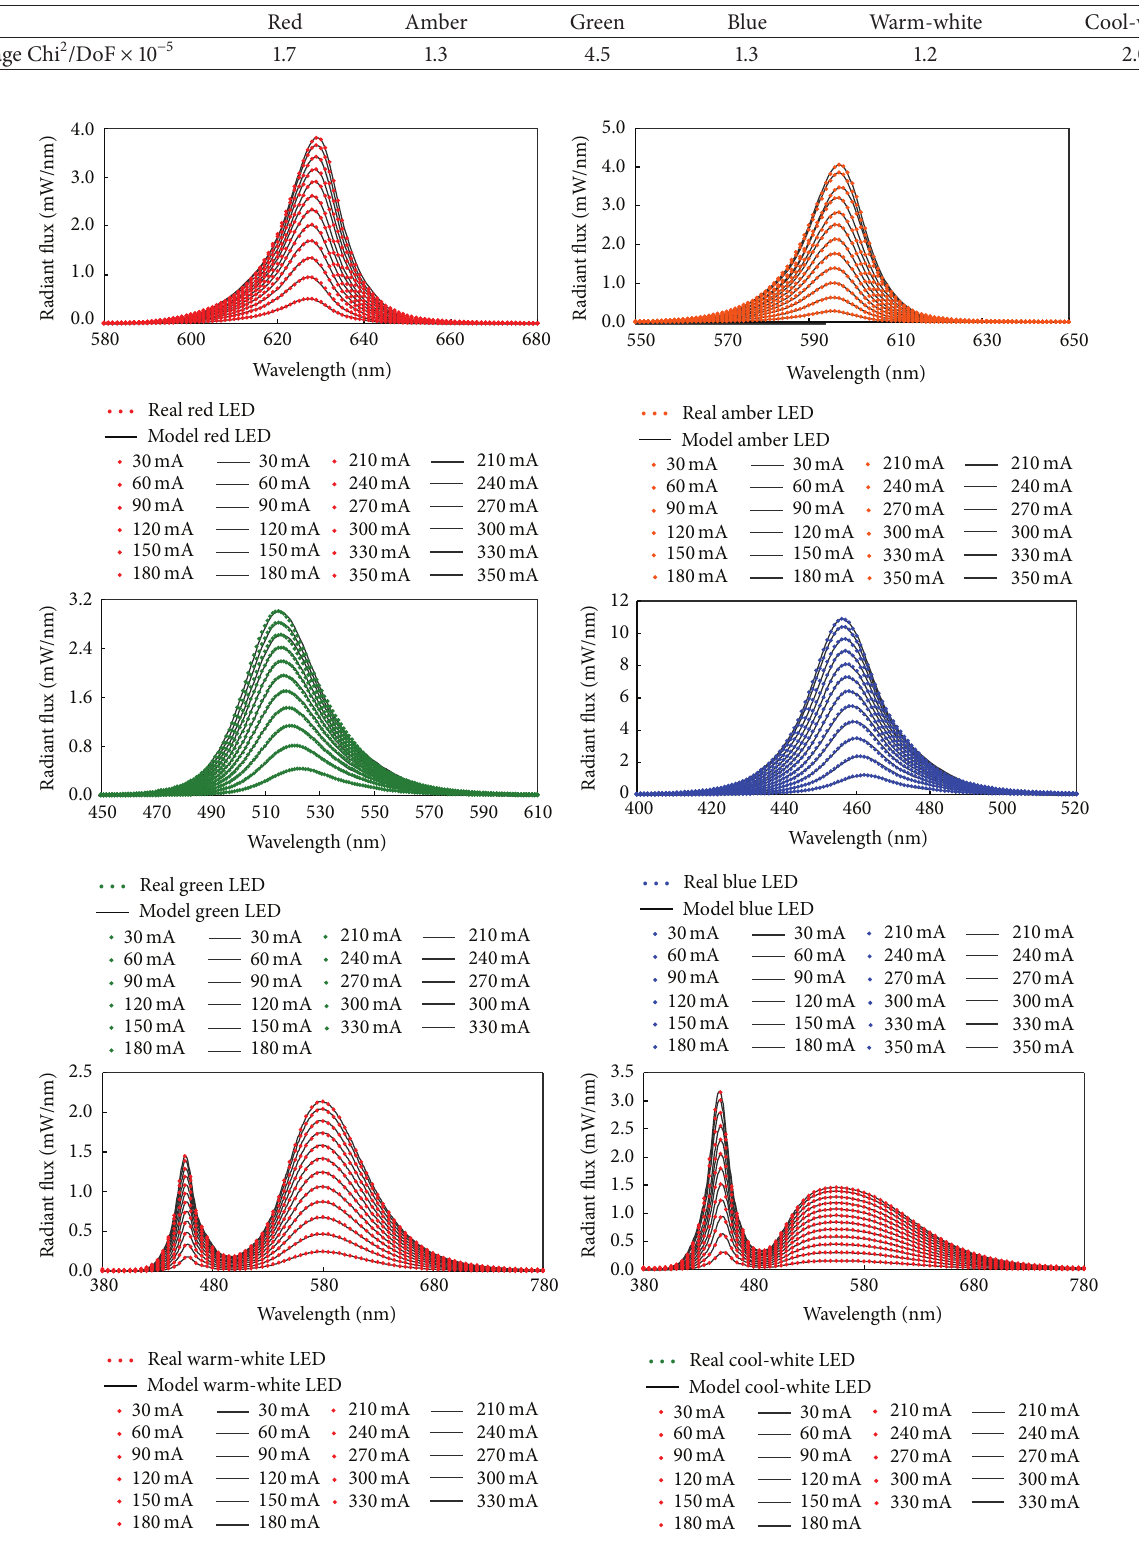
Table 1: Average Chi-square per degree of freedom (Chi 2 /DoF) for the model and real SPDs of these LEDs at different drive currents. LED Red Amber Green Blue Warm-white Cool-white Average Chi 2 /DoF × 10 −5 1.7